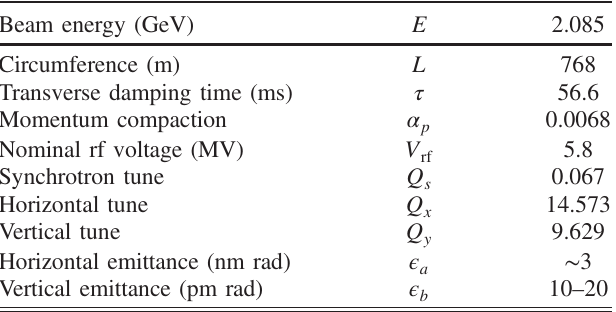
TABLE I. CESRTA machine